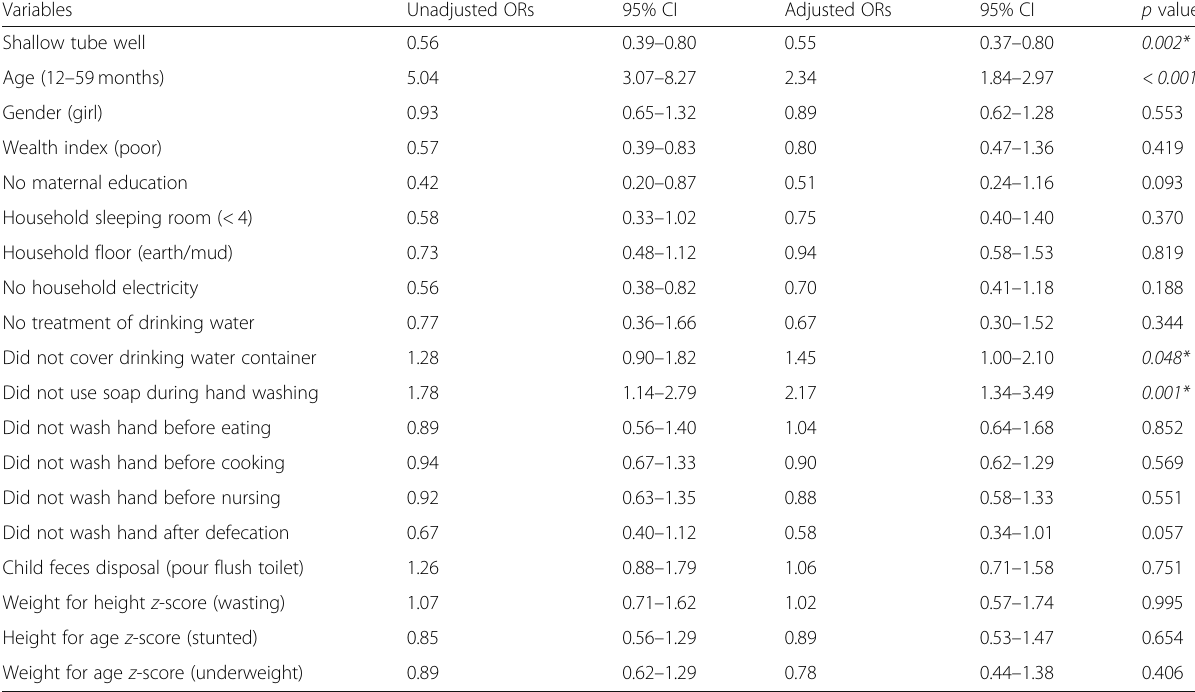
Table 4 Association between Shigella sonnei infection, tube well use, and other factors in rural Mirzapur (number of subjects: